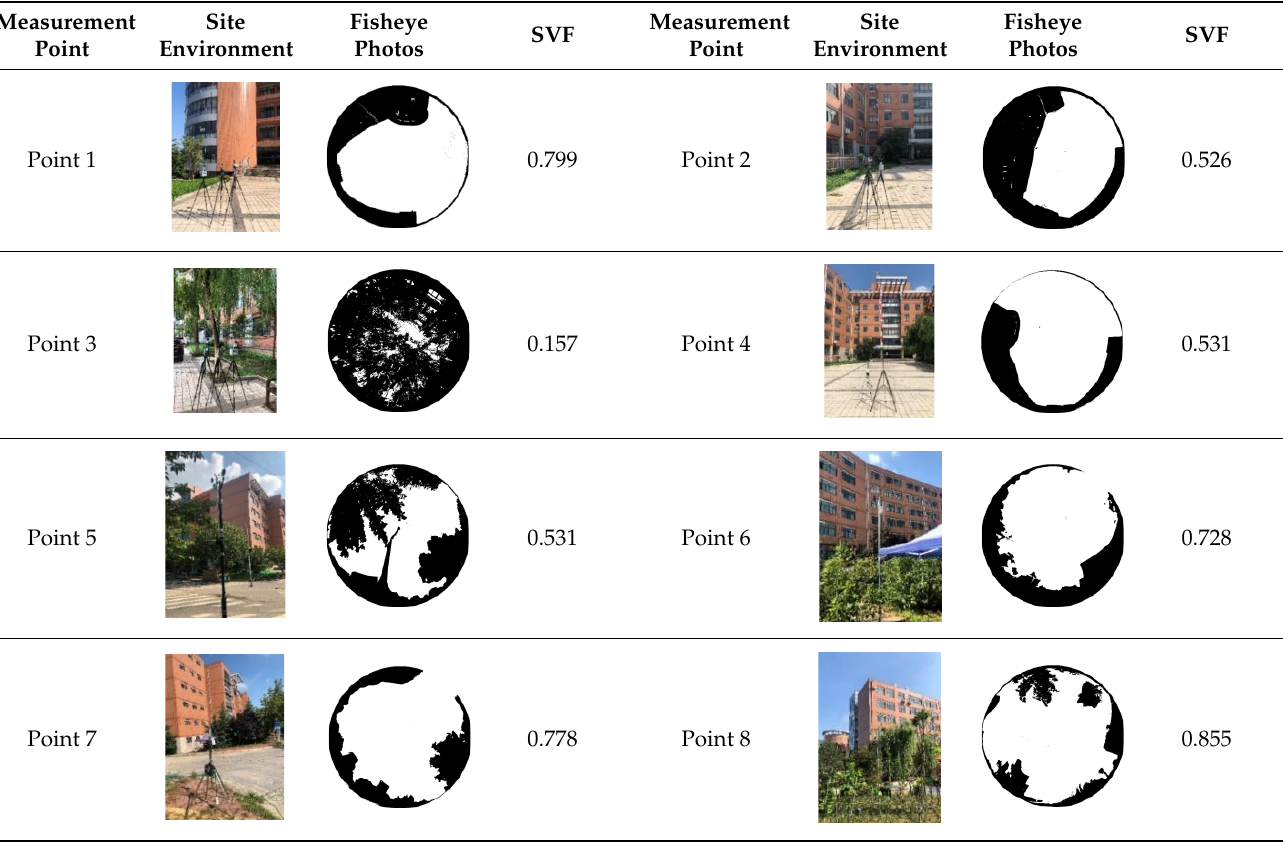
Table 2. The measurement parameters and devices used for monitoring.